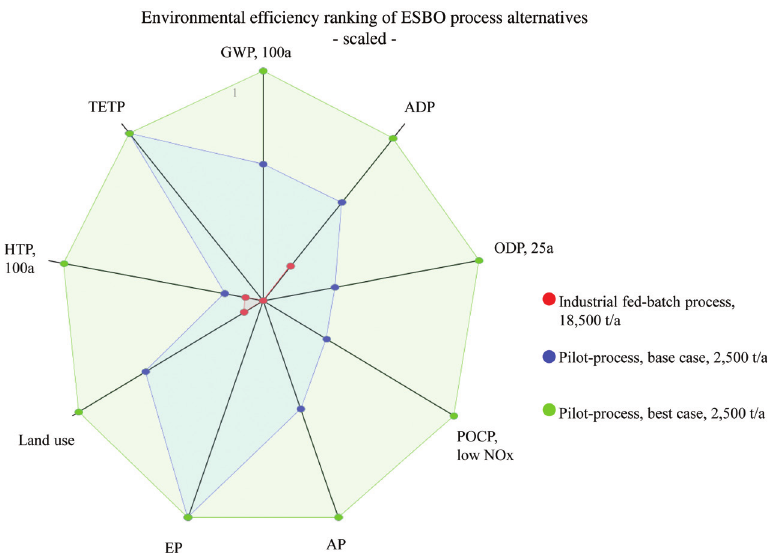
Figure 5 Multi-criteria ranking of epoxidized soybean oil (ESBO) process alternatives (industrial fed-batch, 18,500 t/a; pilot process, base case, 2,500 t/a; pilot process, best case, 2,500 t/a) concerning environmental efficiency (saving potential) taking into account several LCIA